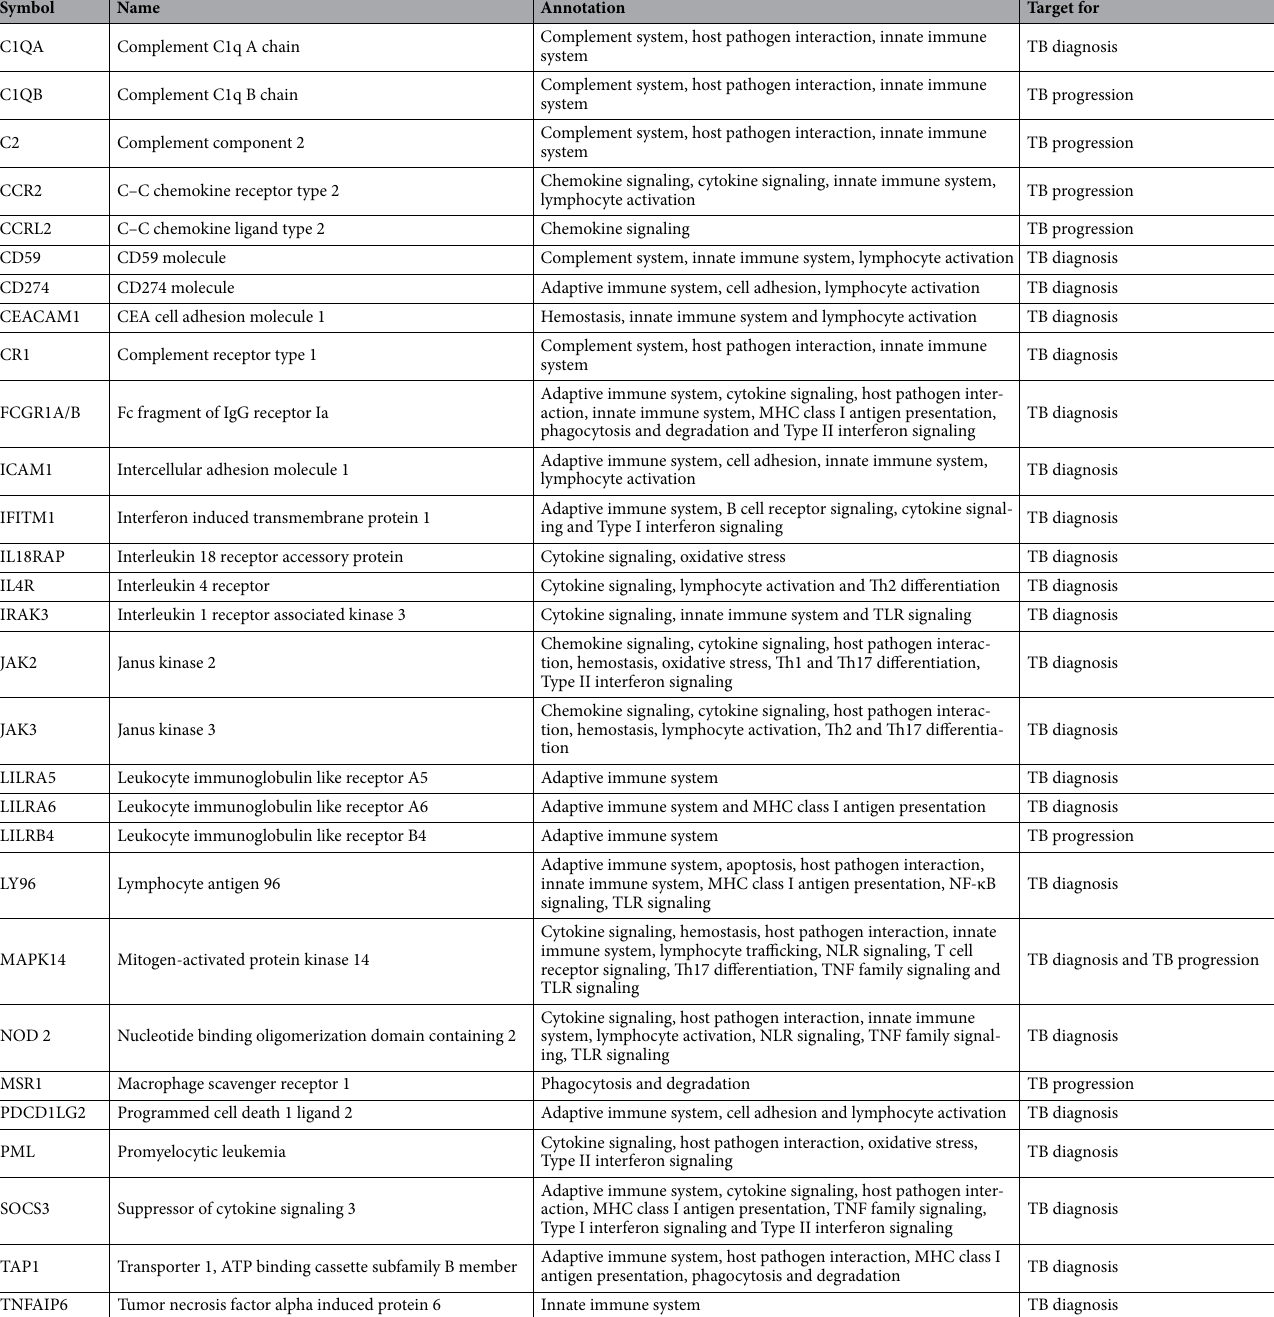
Table 4. Annotation of selected genes based on ROC curve analysis. TB Tuberculosis, LTBI latent tuberculosis